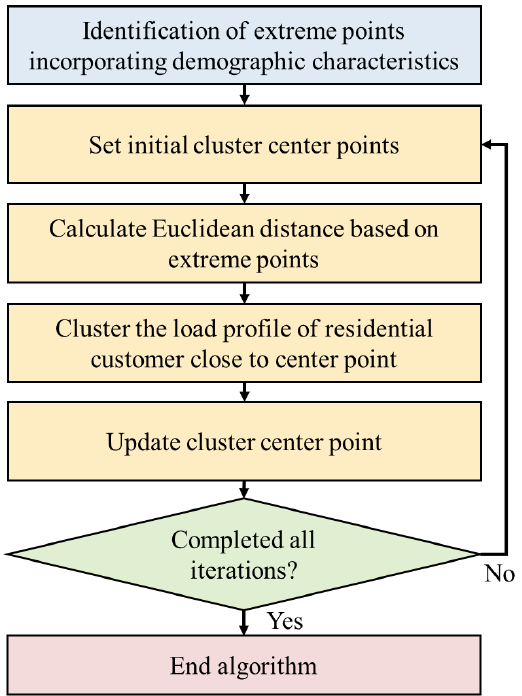
Figure 3. Clustering method using extreme points and demographic characteristics.